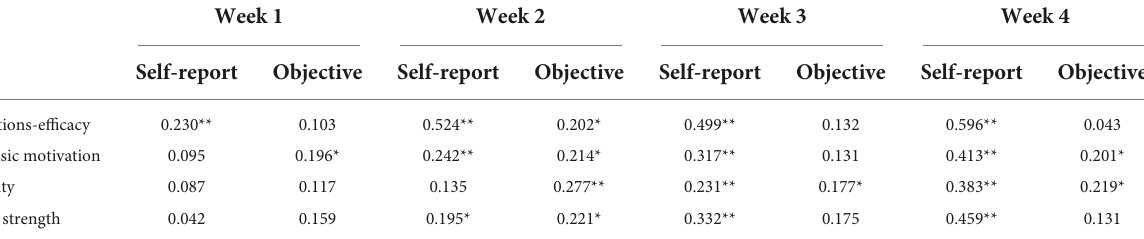
TABLE 1B Correlation results for exercise